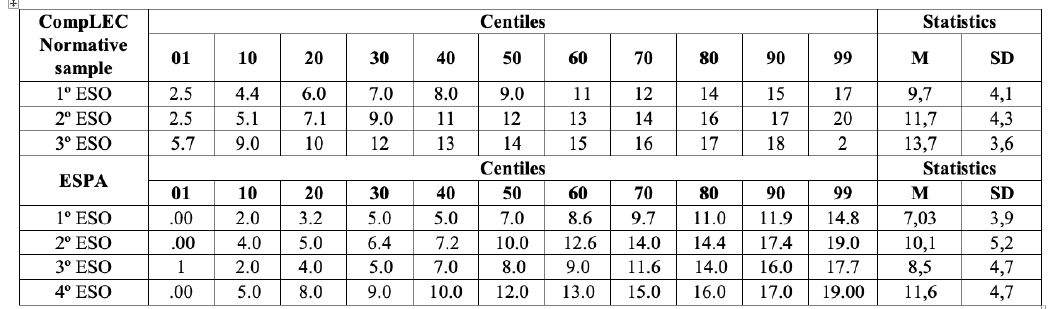
Table 2. Comparison between percentiles of reading competence in